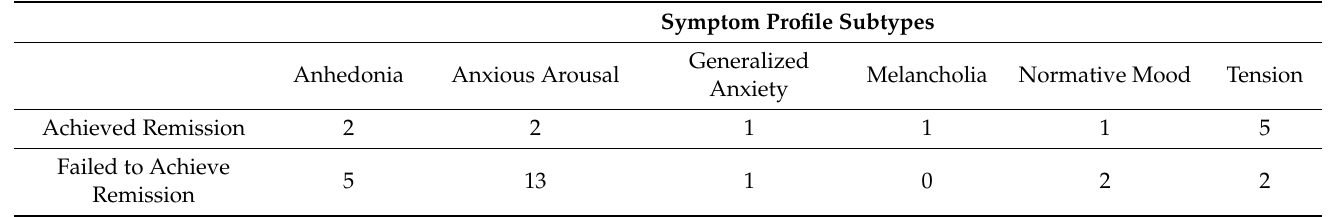
Table 1. Baseline symptom clusters and remission rates after